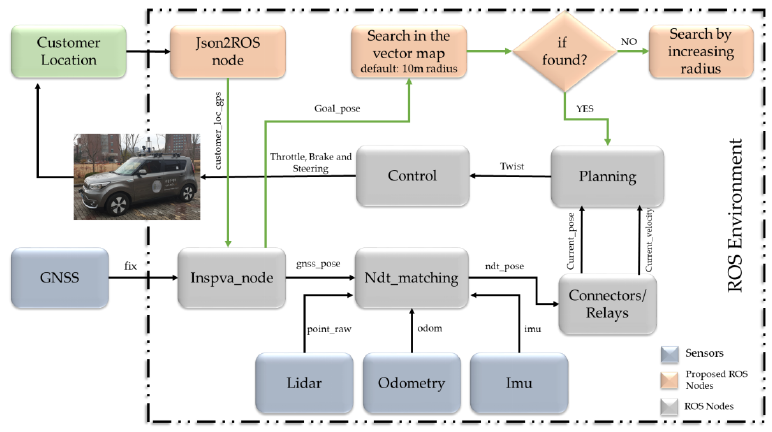
Figure 23. The detailed architecture of converting the autonomous vehicle to a cab service (Best viewed in